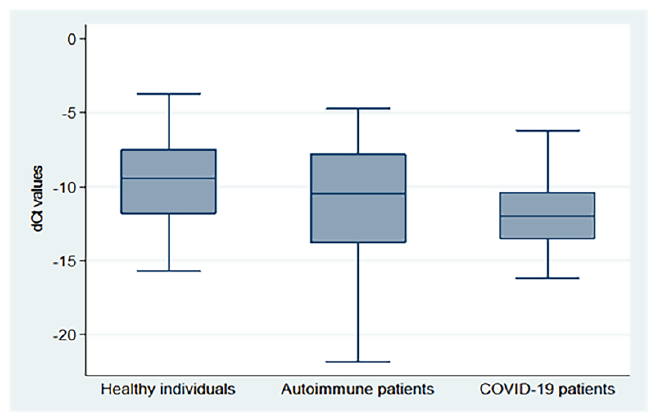
Figure 1. dCt (CtTBP−CtsjTREC) values for healthy individuals, autoimmune patients, and COVID- 19 patients. Table 2. Comparisons of sjTRECs levels (mean dCt values) between the healthy group, autoimmune patients, and COVID-19 patients, according to their gender and age. Healthy